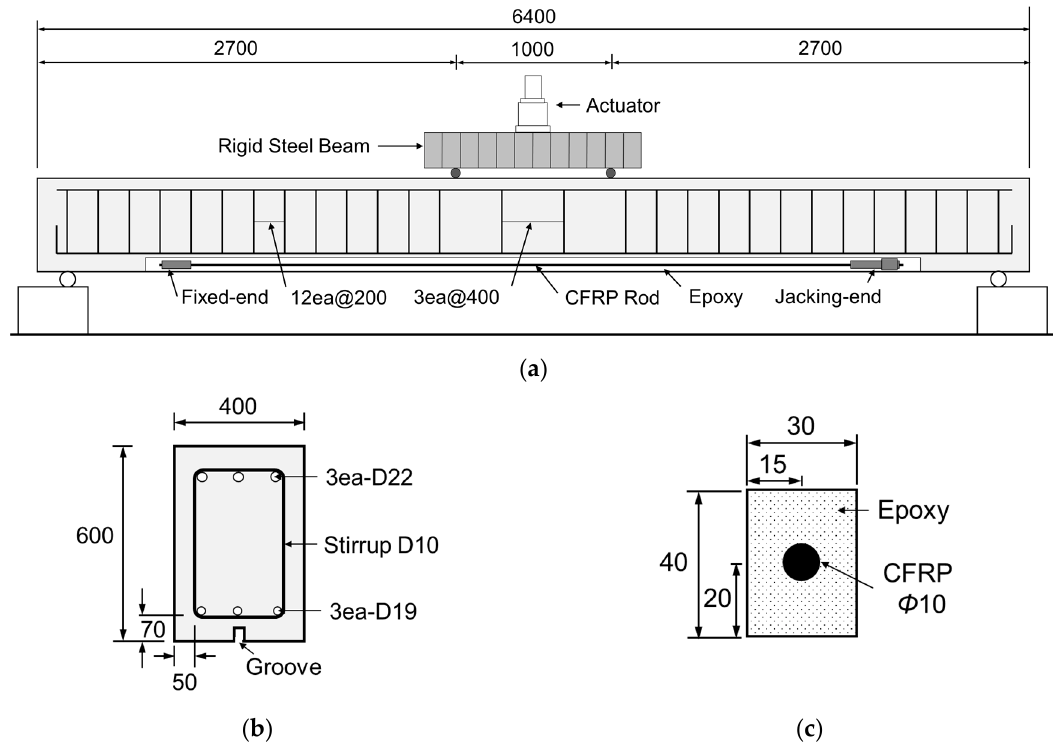
Figure 2. Test setup and beam details (all dimensions are in mm): ( a ) beam dimensions; ( b ) cross section; ( c ) groove.